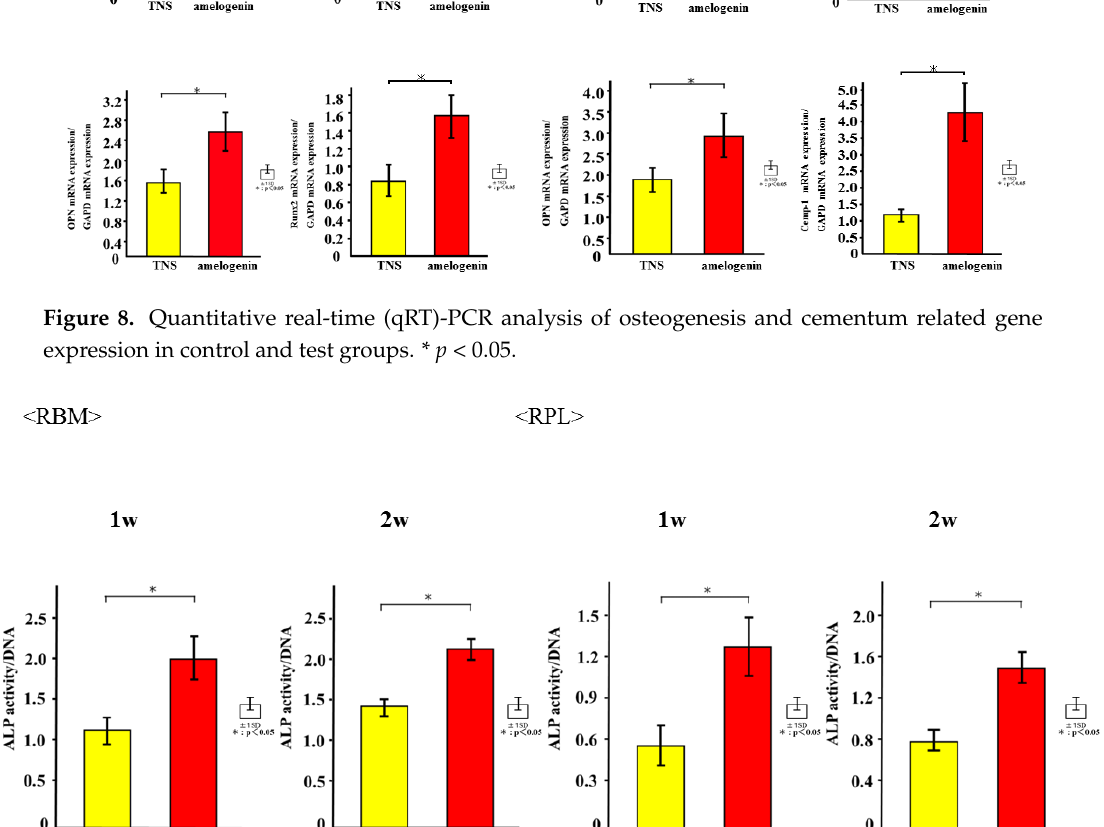
Figure 9. ALP activity in control and test groups. * p < 0.05.